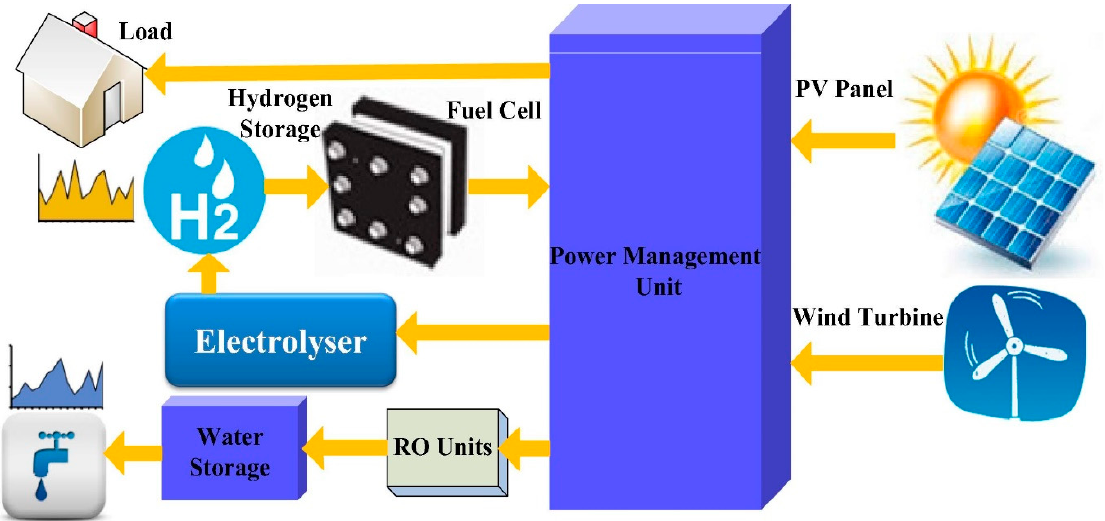
Figure 10. Schematic of examined hybrid renewable energy system [110], reused with permission from Elsevier (license number 5491441217120).